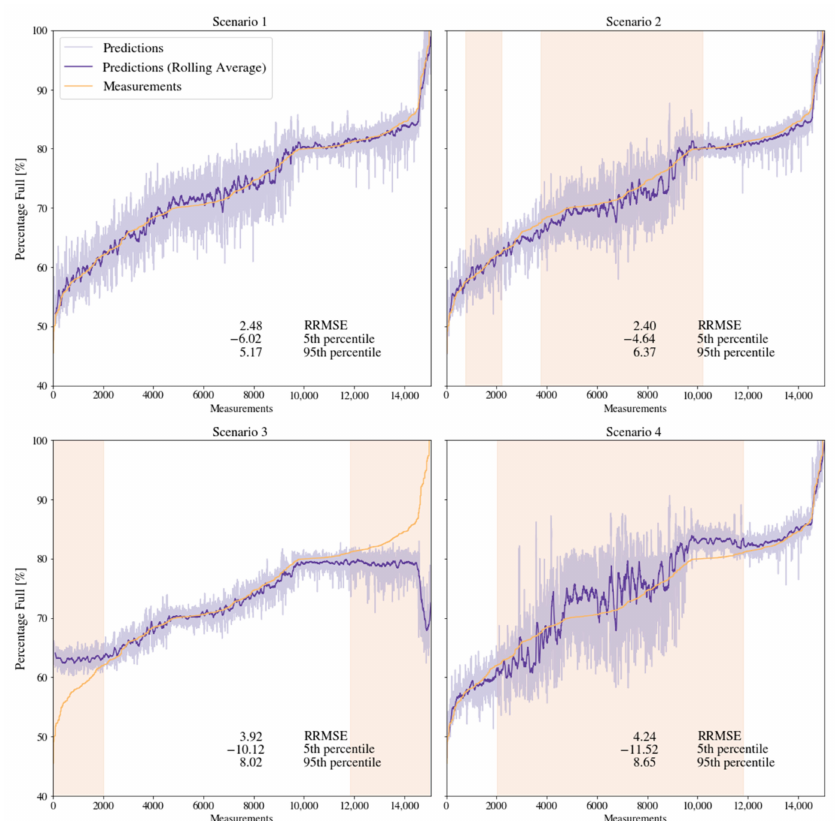
Figure 4. Water level prediction and relative errors for Scenario 1—base case, Scenario 2—two gaps, Scenario 3—no extreme values, and Scenario 4—only extreme values. Shaded areas represent missing training data, i.e., water levels that were never observed during training and need to be fully interpolated by the network. Underneath each scenario, the predictor performance is summarized with the error band of [5th percentile error, relative root mean squared error, 95th percentile